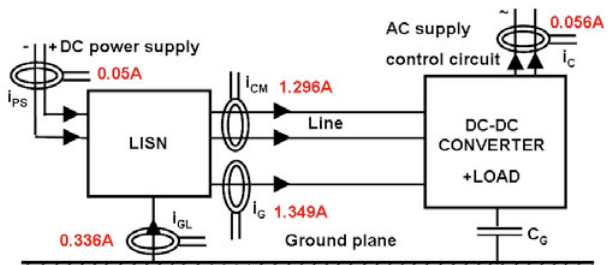
Figure 29: Maximum values of CM currents without filter.